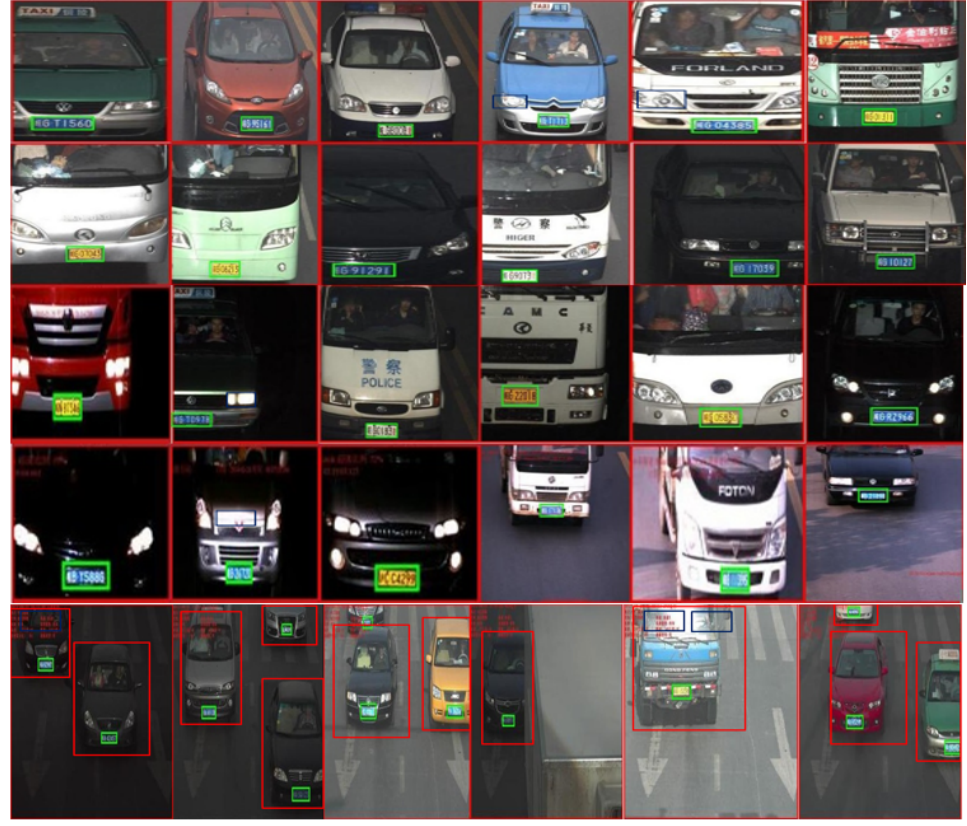
Figure 2. Detection results: first row: G1; second row: G2; third row: G3; fourth row: G4; and fifth row: G5. Table 3. Vehicle detection